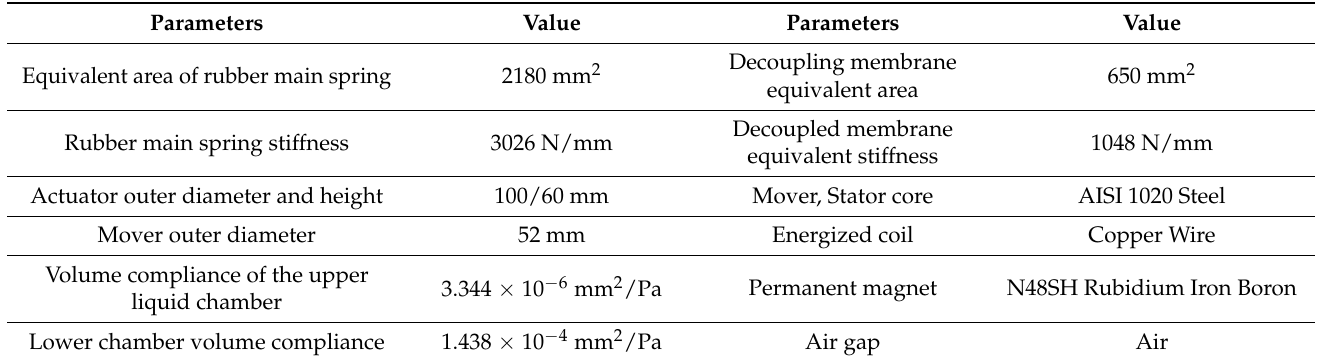
Table 1. The structural parameters and composition materials.